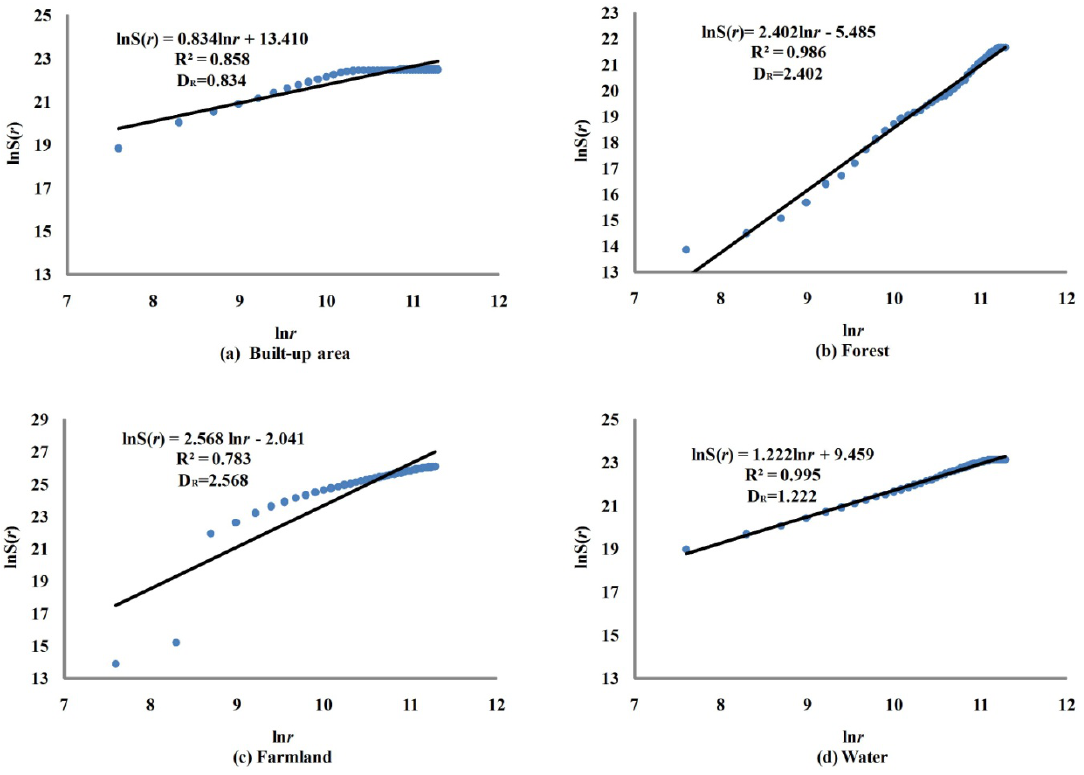
Figure 7. The radius dimension results for four land use types in Wuhan City: ( a ) Built-up area, ( b ) Forest, ( c ) Farmland and ( d )